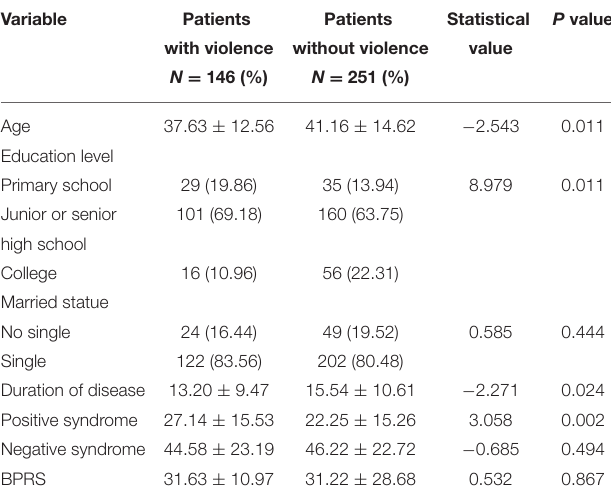
TABLE 1 | Main demographic and clinical characteristics of